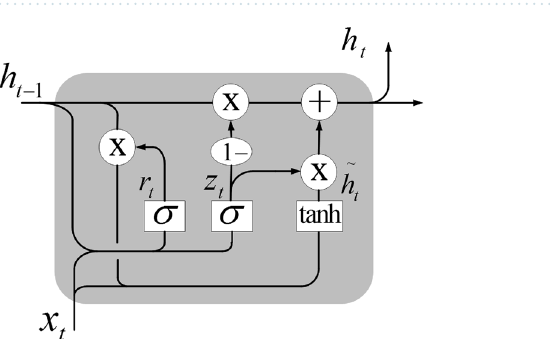
Figure 3. Attention mechanism in the separation framework 27 .